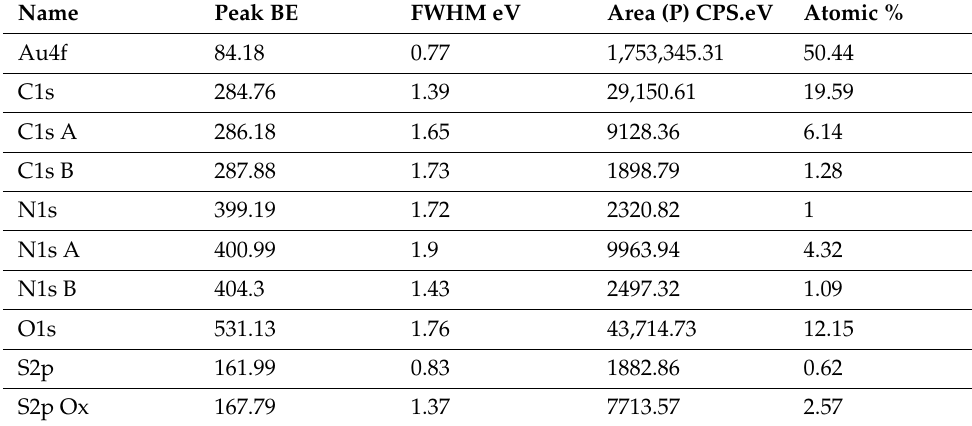
Figure A3. XPS spectra (C1s, S2p, N1s, O1s) of a bare Au plate electrode. Table A2. Characteristics of the XPS peaks, attribution and atomic percentage for an Au surface modified with 1-azido-6-thiohexane (Product 3).